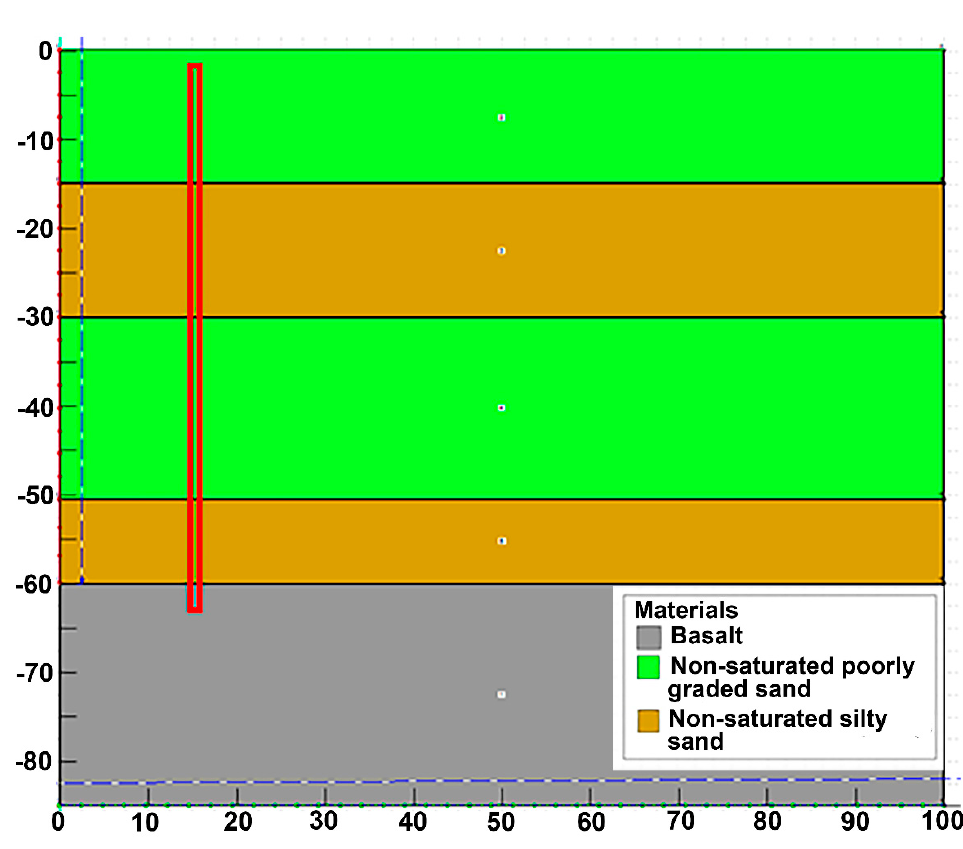
Figure 4. Geometry of the numeric model in SEEP/W.